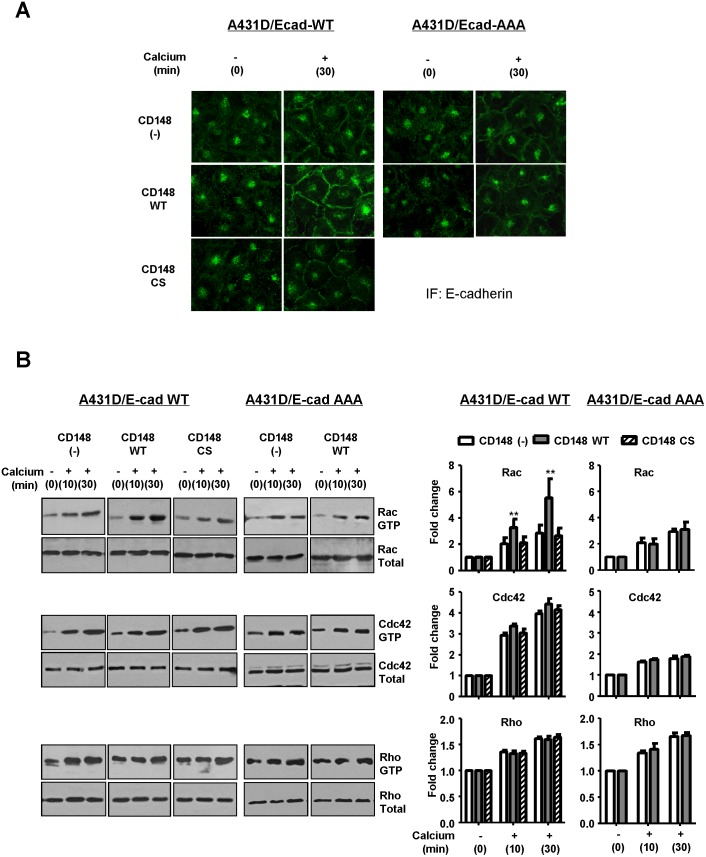
CD148 promotes E-cadherin contact formation with an increase in Rac1 activity.
A) Effects of CD148 in E-cadherin contact formation were examined by a calcium-switch assay and immunofluorescence staining. CD148 WT, but not CS, promotes E-cadherin contact formation in A431D/E-cadherin WT cells, as evidenced by the expanded and intense E-cadherin distribution (left panels), while CD148 WT shows no effects in A431D/E-cadherin 764 AAA cells (right panels). B) Activities of Rac1, Cdc42, and RhoA were measured in the condition of calcium switch assay. Active and total levels of Rac1, Cdc42, and RhoA proteins were assessed by the pull-down assays and/or immunoblotting described in the “Materials and Methods” (left panels). The activity was normalized to total amount of protein using densitometry and expressed as fold change (right panels). The data show means ± SEM of quadruplicate determinations. **P<0.05 vs. CD148 (−) cells.